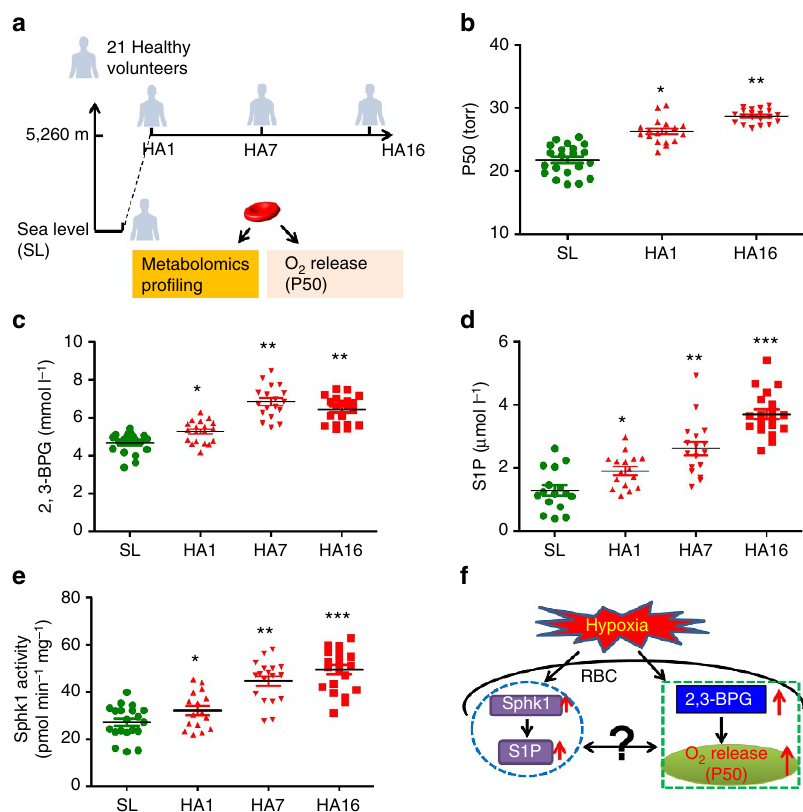
Figure 1 | Concurrent increase of erythrocyte Sphk1 activity, S1P production and O 2 delivery ability in human high-altitude study. ( a ) Schematic representation of human high-altitude study: nonbiased metabolomic profiling coupled with erythrocyte function analysis was performed on the erythrocytes isolated from 21 human volunteers at sea level (SL), and after 12h (HA1), 7 days (HA7) and 16 days (HA16) at 5,260m altitude. ( b ) Erythrocyte O 2 release capacity was measured as P50. 2,3-BPG level ( c ) and S1P level ( d ) were quantified in human high-altitude samples. ( e ) Erythrocyte Sphk1 activity in human high-altitude samples. ( f ) Schematic representation showing concurrent increase of erythrocyte S1P metabolism with O 2 delivery identified in human high-altitude study. Mean ± s.e.m; n ¼ 16–21 per group; * P o 0.05 versus SL, ** P o 0.01 versus HA1, *** P o 0.01 versus HA7, two-way ANOVA. signals were detected in tissue sections of WT or Sphk1 (cid:2) / (cid:2) mice